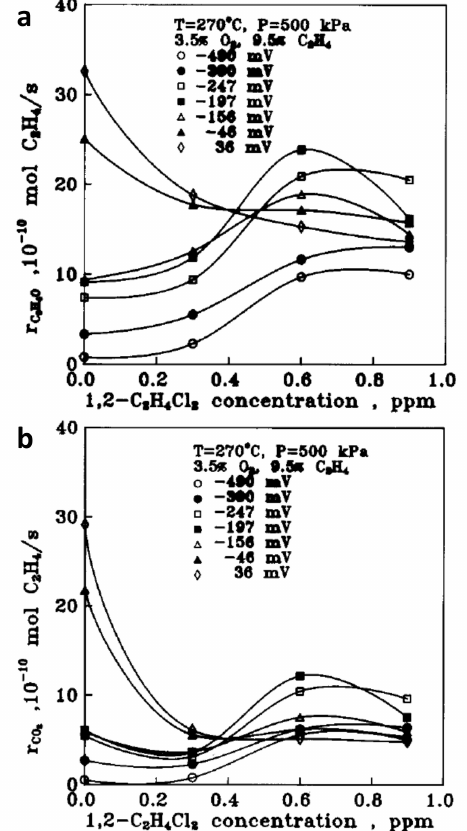
Figure 2. Ethylene oxide ( a ) and CO 2 ( b ) production rates on an Ag / YSZ electrochemical catalyst and tested for ethylene epoxidation reaction with di ff erent C 2 H 4 Cl 2 gas phase concentrations and applied catalyst potentials (V WR ). Reprinted with permission from